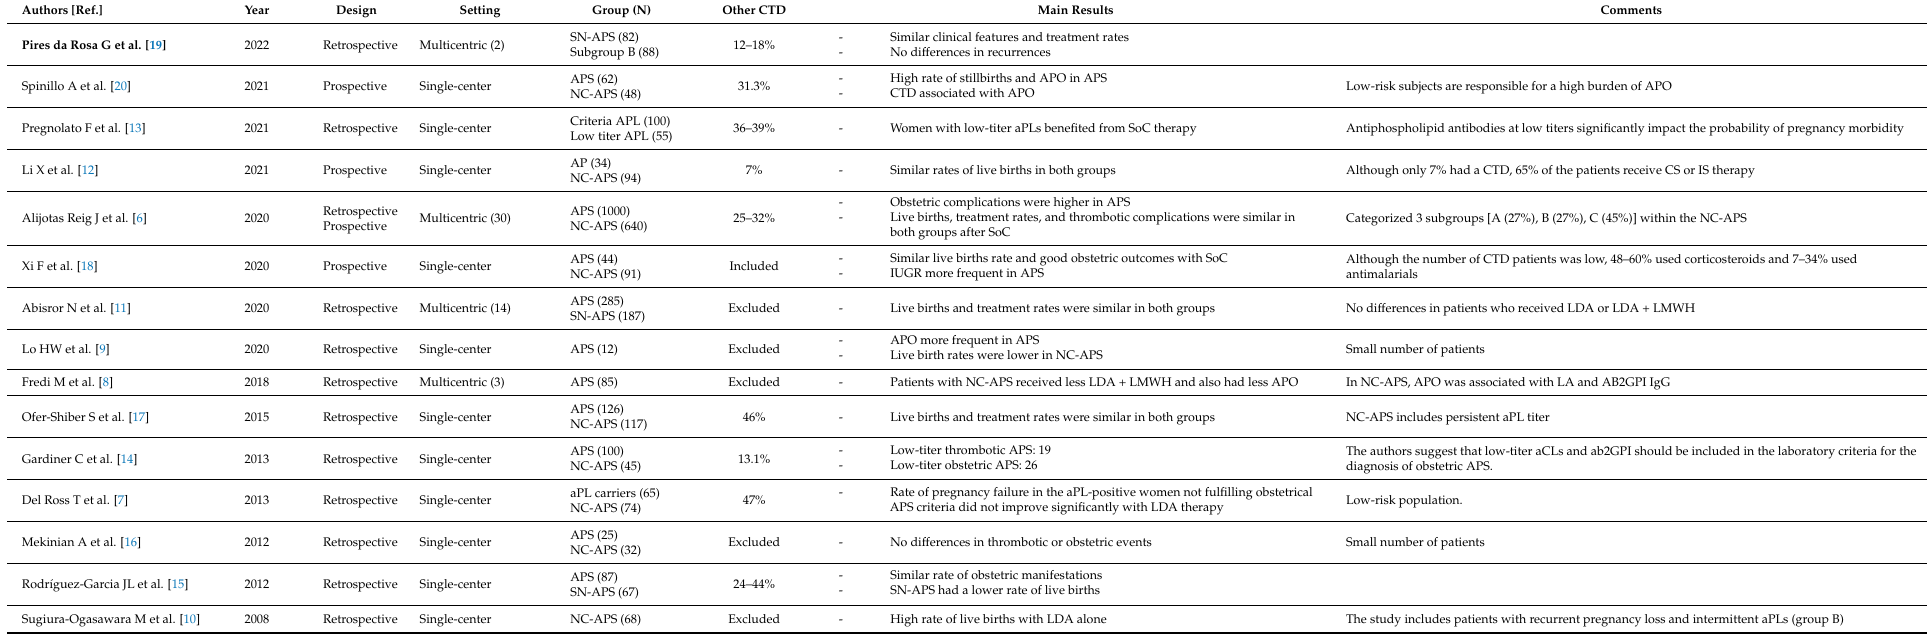
Table 1. Main studies on non-criteria obstetric antiphospholipid